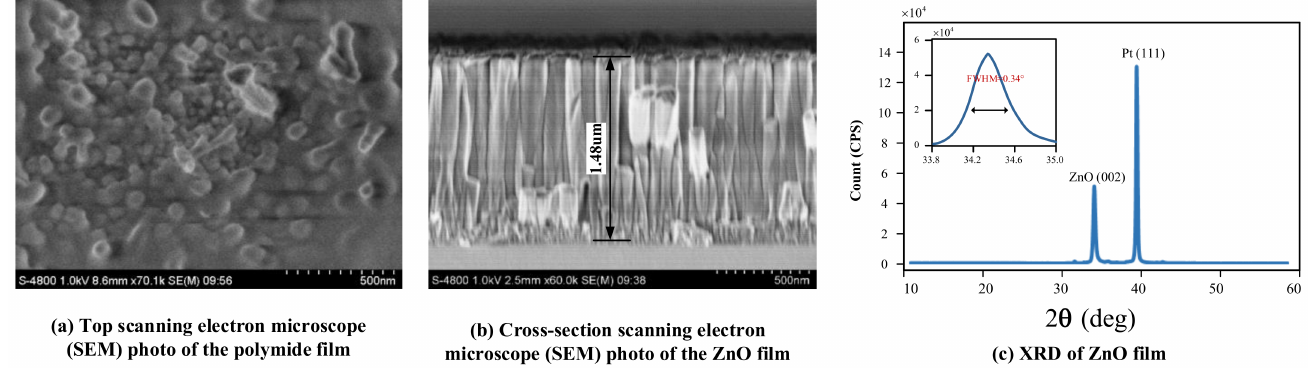
Figure 6. ( a ) Top scanning electron microscope (SEM) photo of PI film; ( b ) Cross-section SEM of ZnO piezoelectric film; ( c ) XRD pattern of ZnO